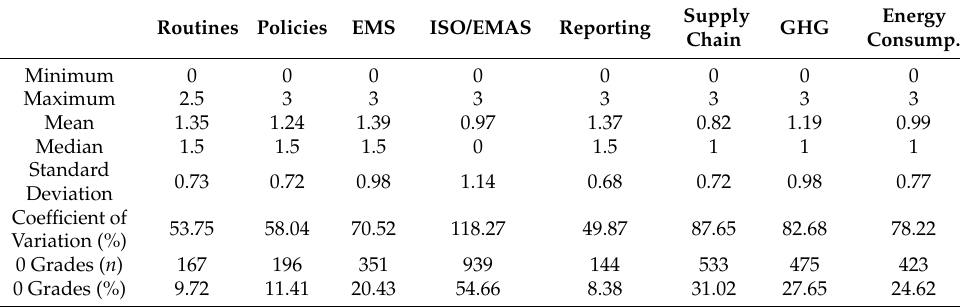
Table 4. Basic statistics of grades achieved in